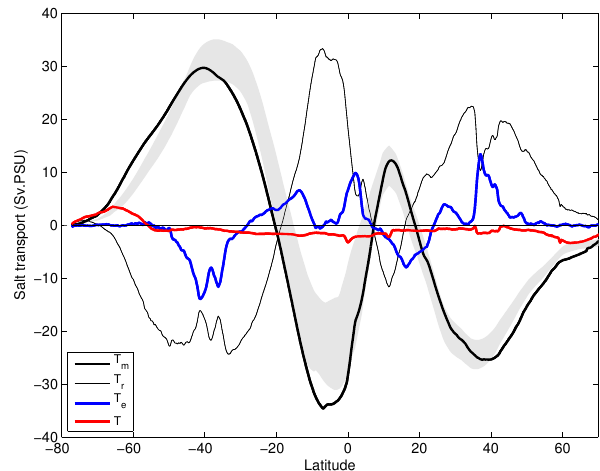
Fig. 3. Meridional transport resulting from the surface water flux in the ORCA12 model (Sv, thick black line), and comparison with Large and Yeager (2009). The grey shading is the envelope of all an- nual transports resulting from the air–sea fluxes of Large and Yea- ger (2009) for years 1984 to 2006 (these fluxes are a combination of observations and the NCEP reanalysis). The thin black line is the meridional transport computed directly from the model meridional velocities.